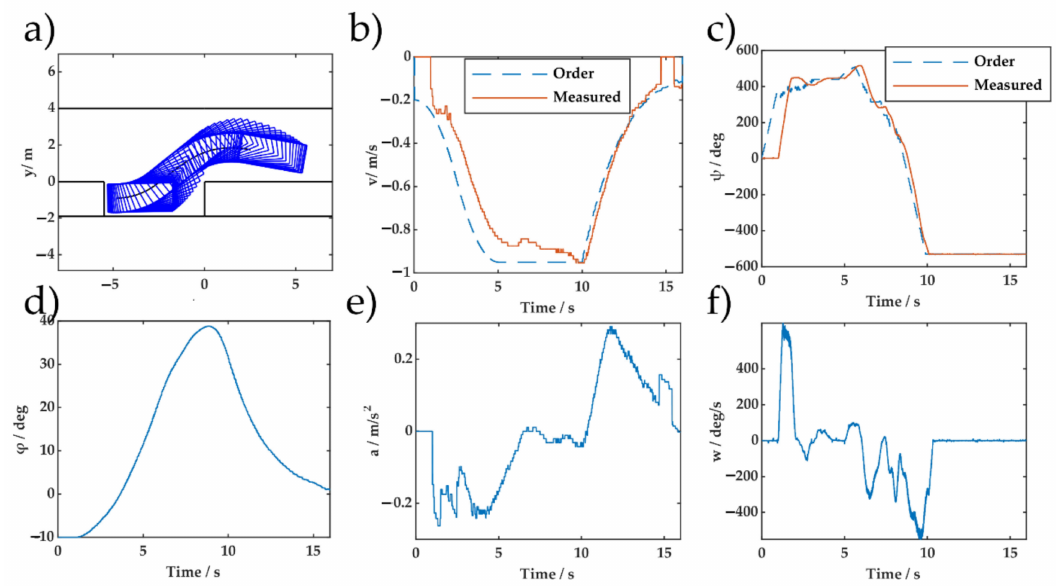
Figure 15. Experimental parking control and state profiles of DERL for the initial pose (2.5 m, 1.75 m, − 10 ◦ ): ( a ) Parking trajectory; ( b ) speed profile; ( c ) steering wheel angle profile; ( d ) orientation angle; ( e ) acceleration; and ( f ) steering wheel